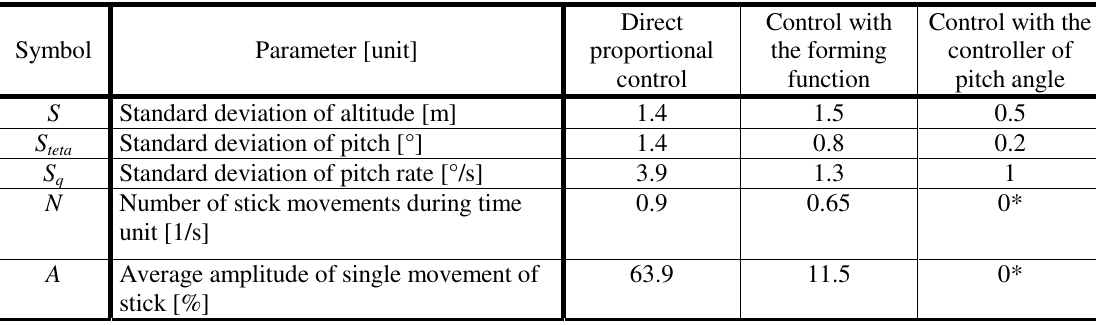
Table. Tested control algorithms modified handling qualities of aircraft– sample parameters